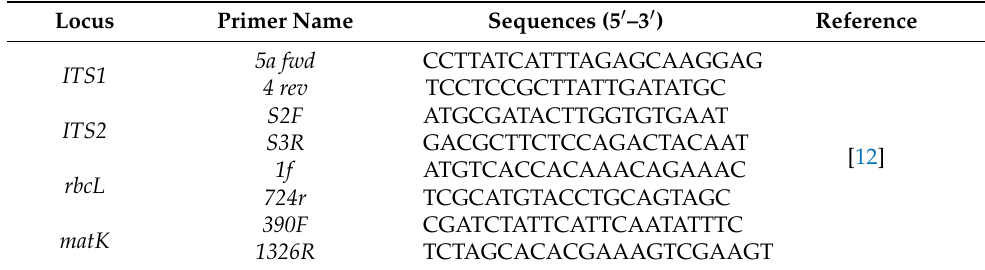
Table 1. The universal primers for DNA barcoding used in this study.